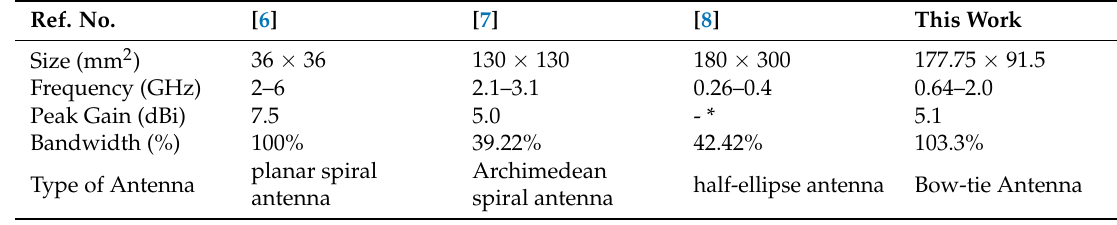
Table 5. Comparison between different antennas with the proposed